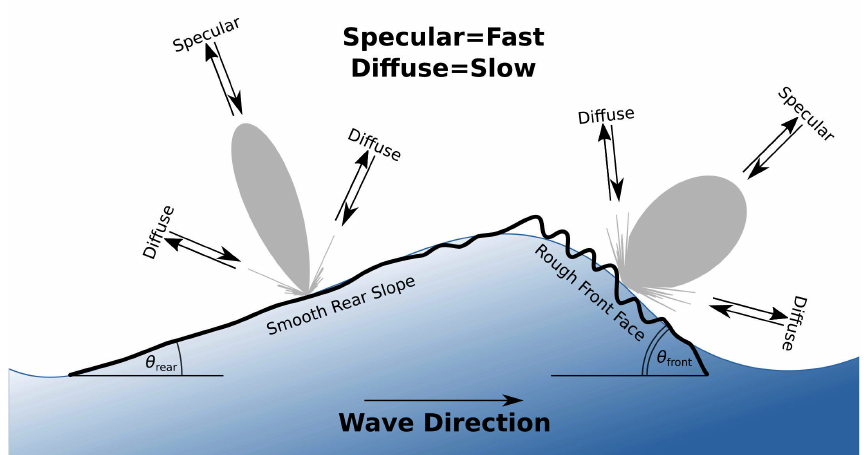
Figure 10. Sketch explaining the speculative model proposed for the experimental data’s